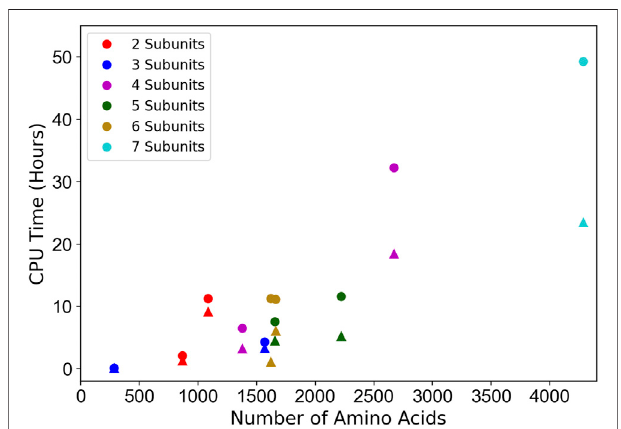
FIGURE7| Computational time relativetotheprotein complexsize. The CPU time of the entire process (circles) as well as the initial subunit pose search step (triangles) are shown. 11 experimental map targets with different numberofchainswereused:EMD-3658,EMD-7327,EMD-0366,EMD- 1495, EMD- 2526, EMD-8475, EMD-6553, EMD-3201, EMD-8796, EMD- 3087, and EMD-6671. The time was measured on 20 cores of AMD EPYC 7402P 24-Core @ 2.8